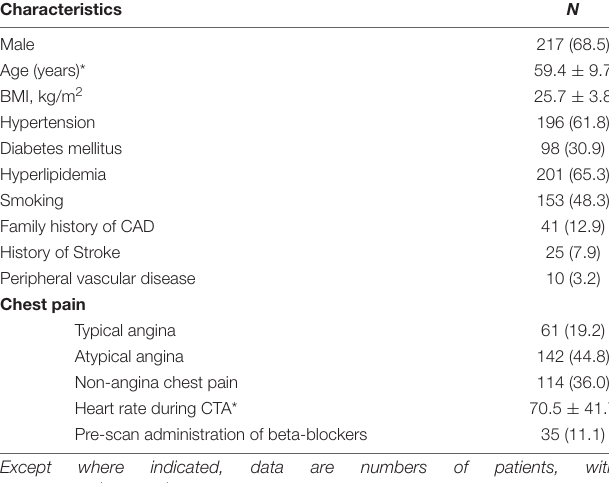
TABLE 1 | Demographic and clinical characteristics of